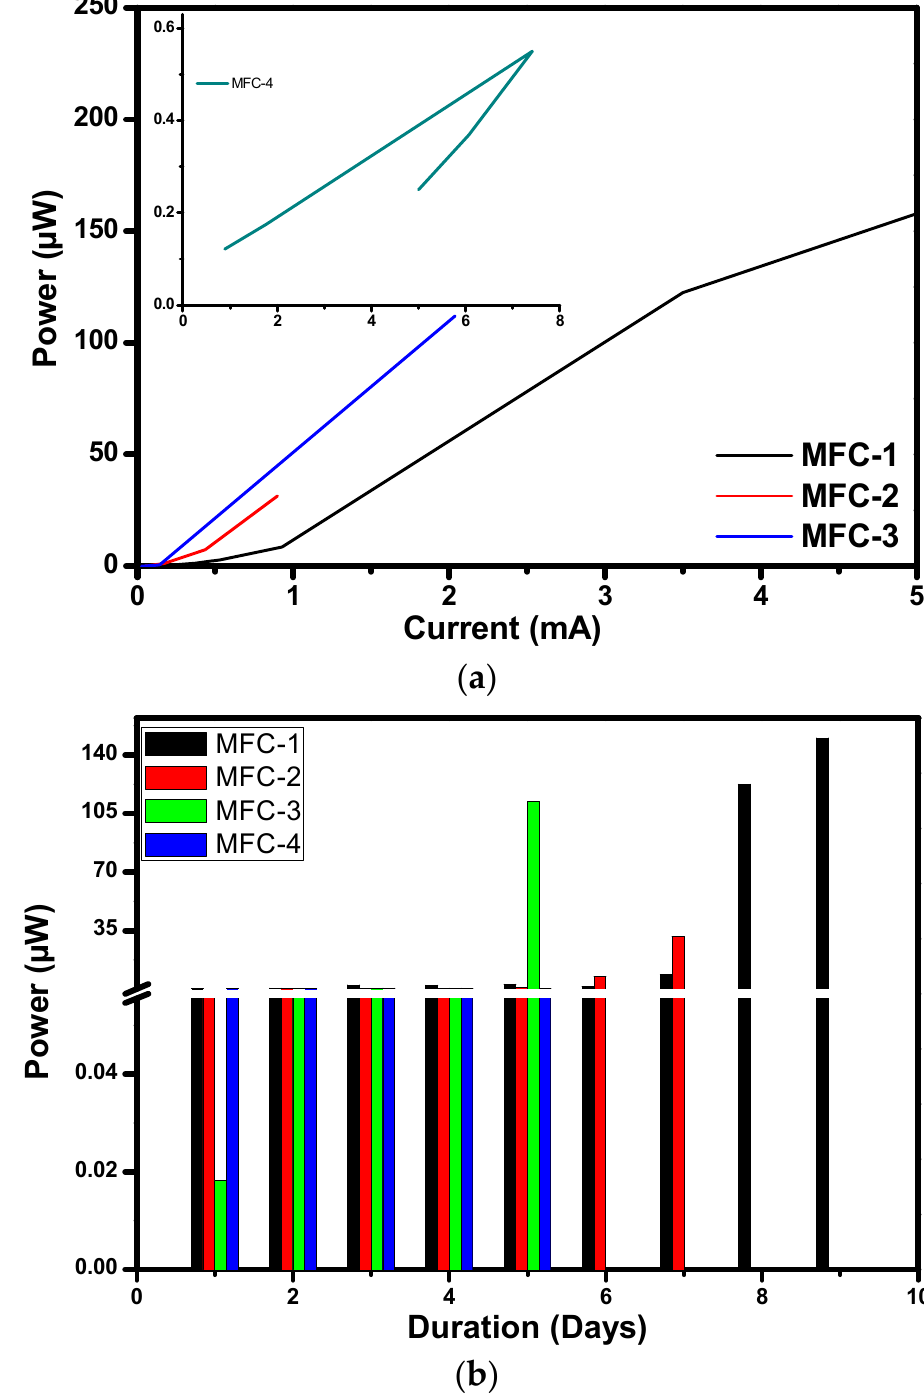
Figure 7. ( a) Current vs. Power for all MFCs; ( b ) Graphical representation of duration vs. power. Figure 7. ( a ) Current vs. Power for all MFCs; ( b ) Graphical representation of duration vs. power. Figure 7a,b provide variation in power concerning the current and duration of Maximum voltage was generated by the cell compared to MFC1–3. In addition, the MFC1–4. Power generated from MFC1 increases from 0.000204 to 13.10 mW from day 1 size and inoculums quantity used was less in MFC4. Further, volumetric power to day 19 with external resistance of 10 Ω . During the first eight days, much less power generation was observed, and from day nine onwards, there was a very sharp increase in power generation. This could be the lesser release of electrons by the microbes during the